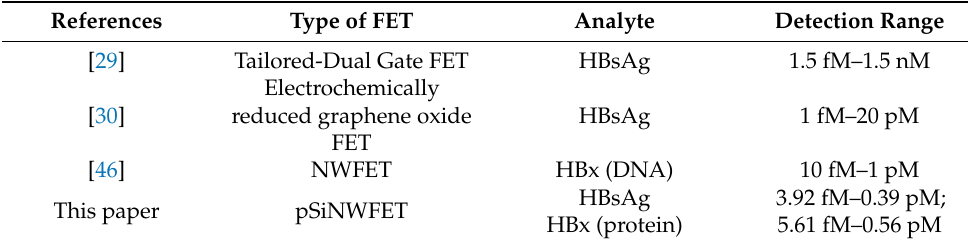
Table 1. List of other FET-based sensors related to HBV